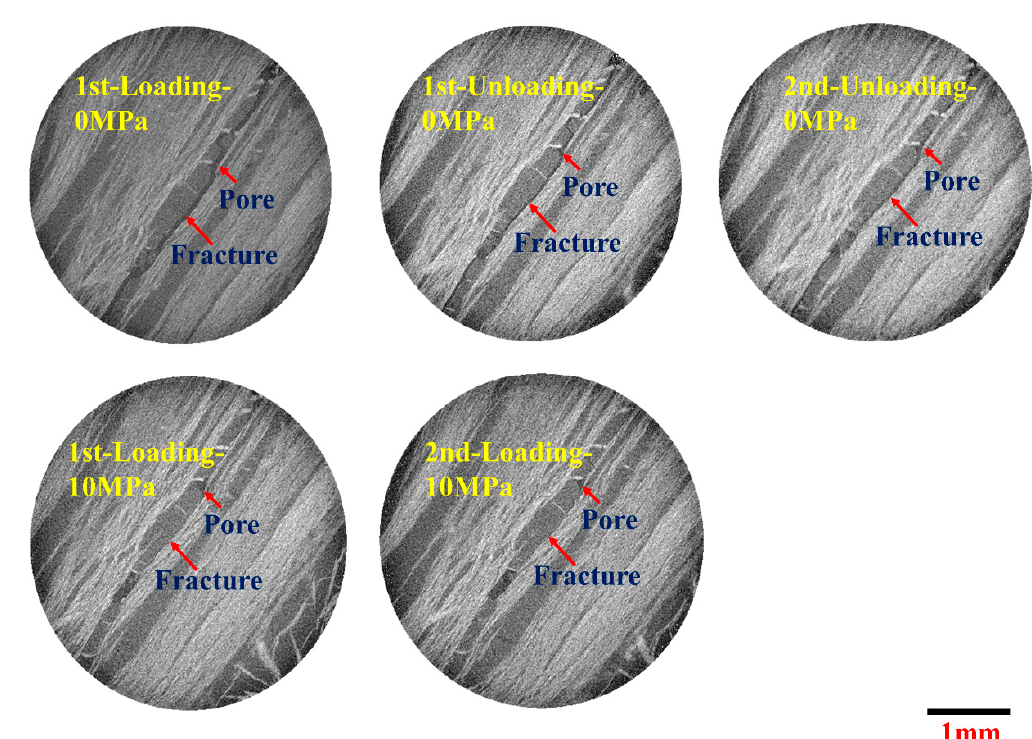
Figure 15. The images of the same position when the confining pressure is 0 MPa and 10 MPa.